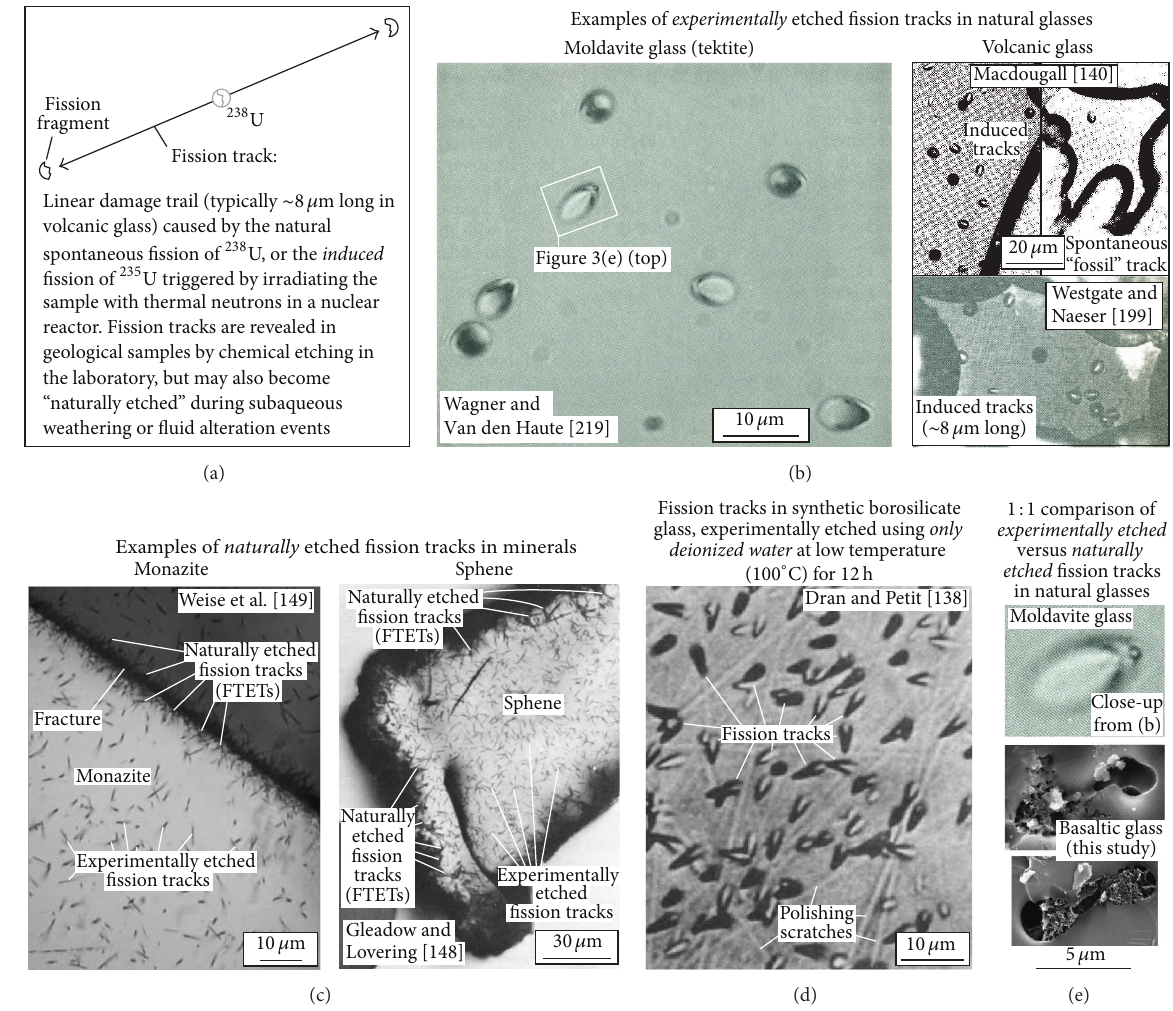
Figure 3: Background on fission tracks and examples of fission track etching. (a) Schematic illustration of a fission track. (b–d) Transmitted light photomicrographs of experimentally etched fission tracks in natural glasses (b), naturally etched fission tracks in minerals (c) (i.e., revealed by fluid alteration along a fracture in monazite (left) or by weathering and corrosion around the outer surface of a sphene grain (right)), and fission tracks in synthetic borosilicate glass (simulated nuclear waste glass) etched only with deionized water (d). (e) Scale comparison (1:1) of an experimentally etched fission track in natural moldavite glass (top), with two “naturally etched” fission tracks in submarine volcanic glass (sample DSDP-418A-75-3[120–123] ; see close-ups and petrographic context of these two fission track etch-tunnels in Figures 11 and